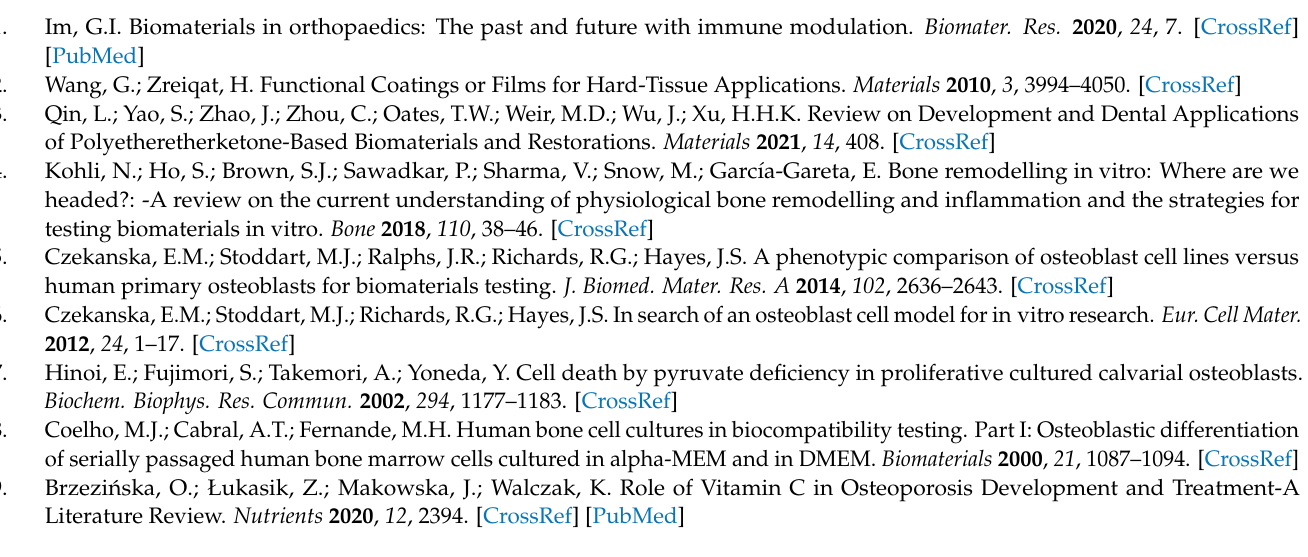
Figure S2: Comparison of protein concentration at 7 days using MC3T3-E1 cells using three types of